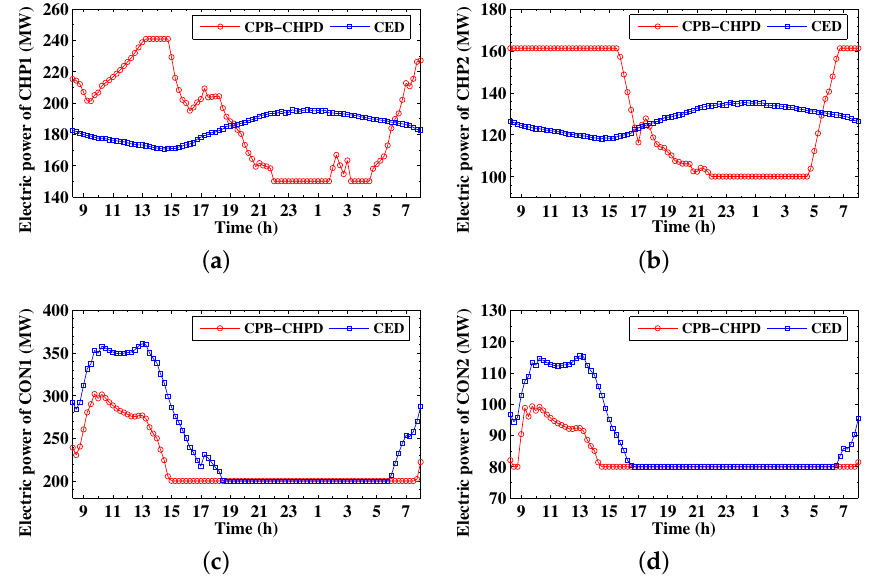
Figure 6. Electric power output of the thermal power units at each period in Case 1: ( a ) the first CHP unit CHP1; ( b ) the second CHP unit CHP2; ( c ) the first CON unit CON1; ( d ) the second CON unit CON2.